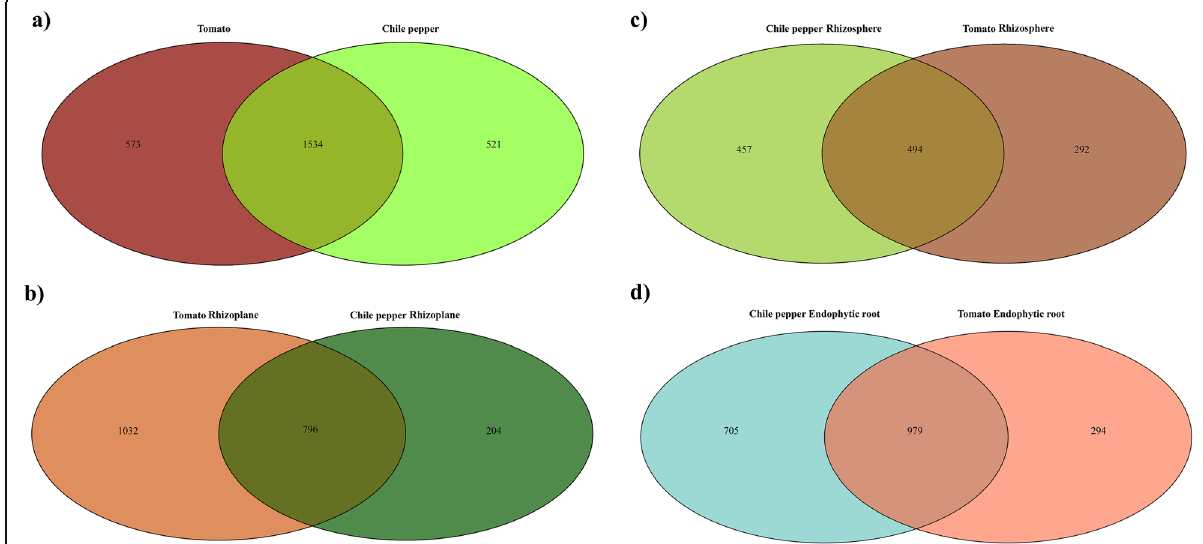
Fig. 6 Analysis of the Bray-Curtis beta-diversity index in the Solanaceae family in a both species, b rhizoplane, c rhizosphere, and d endophytic root